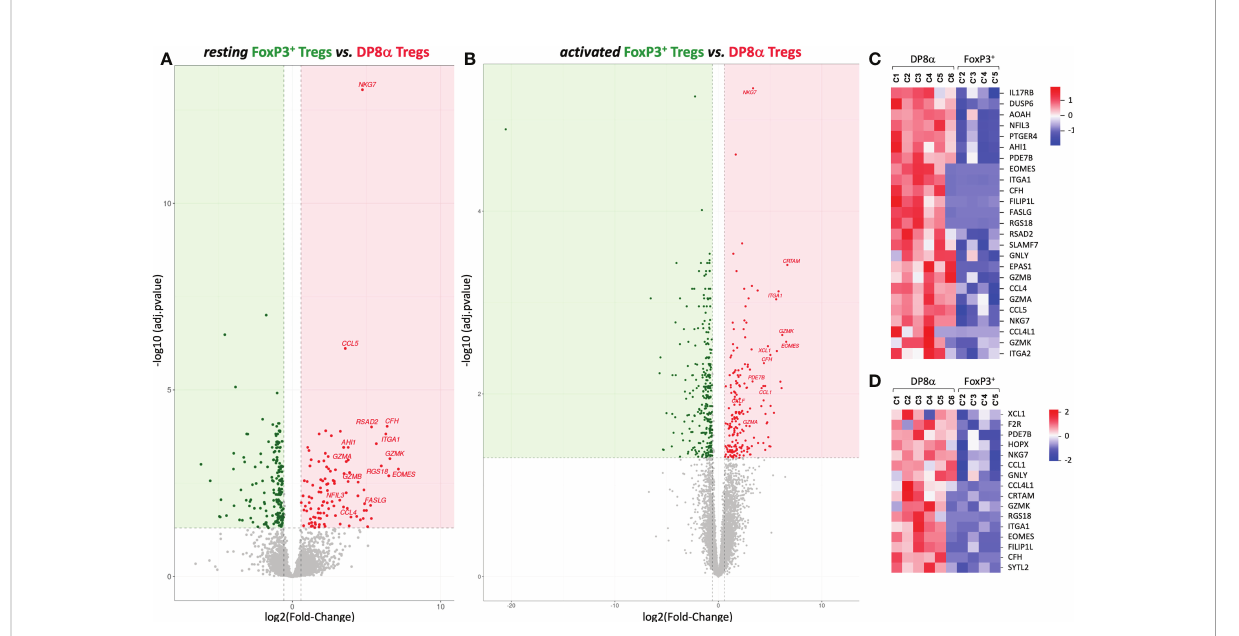
FIGURE 3 Gene expression pro fi les generated from DP8 a and FoxP3 + Treg clones derived from the colonic lamina propria from patients and healthy donors. (A , B) The Log 2-fold changes of average expression values between resting (A) or activated (B) DP8 a and FoxP3 + clones. (C , D) Heat- maps showing normalized expression of top DEGs between resting (C) or activated (D) colon-derived DP8 a and FoxP3 + Treg